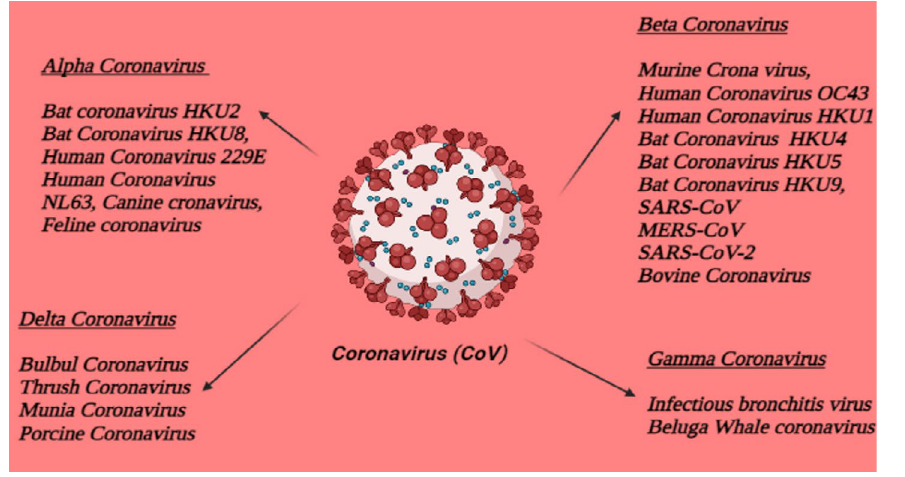
Fig. 2. Classification of Coronavirus.